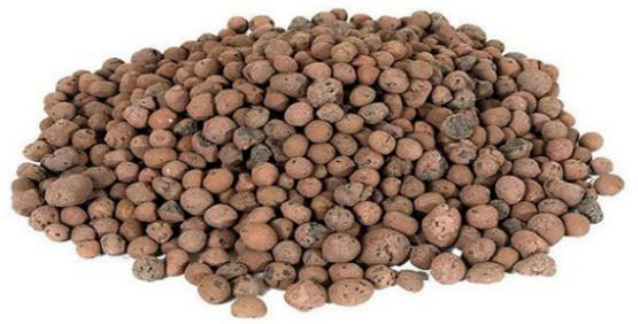
Figure 3. Samples of lightweight lika aggregates. Table 3. Physical properties of normal weight and lightweight aggregates.